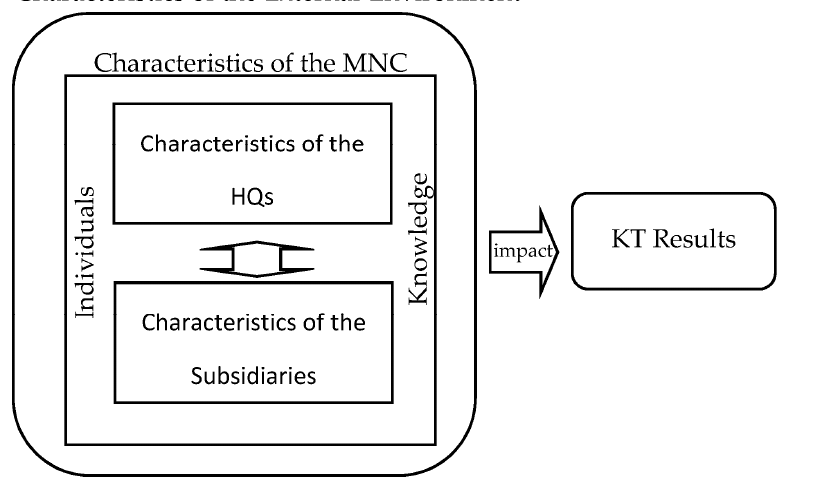
Figure 4. Aggregated framework .